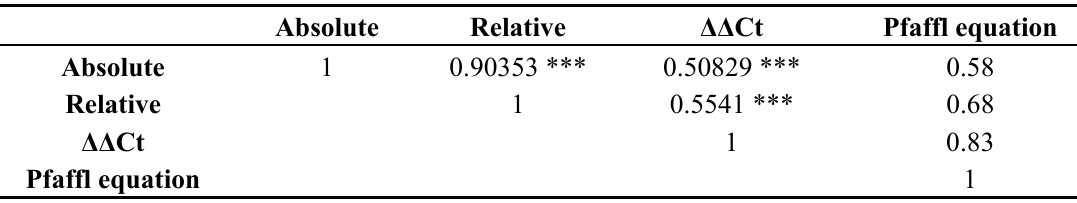
Table 1. Correlation coefficients between four methods used to express the quantity of bacteria using real time